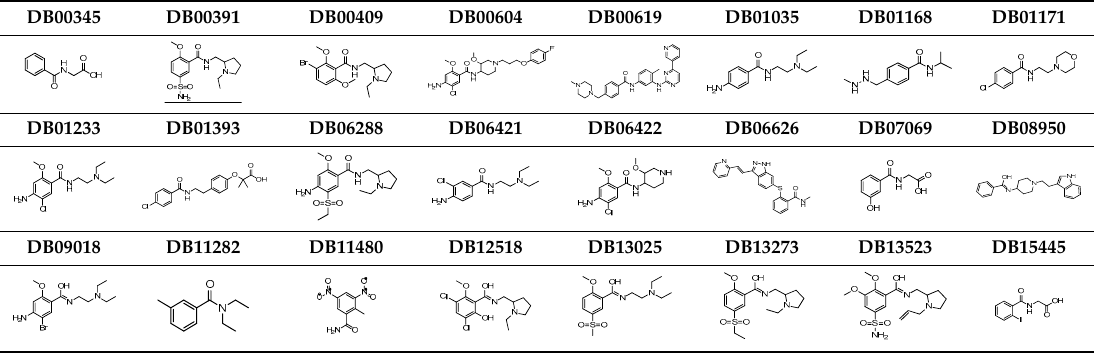
Table 9. Representation for 24 approved drugs containing benzamide scaffold listed in Table 8.